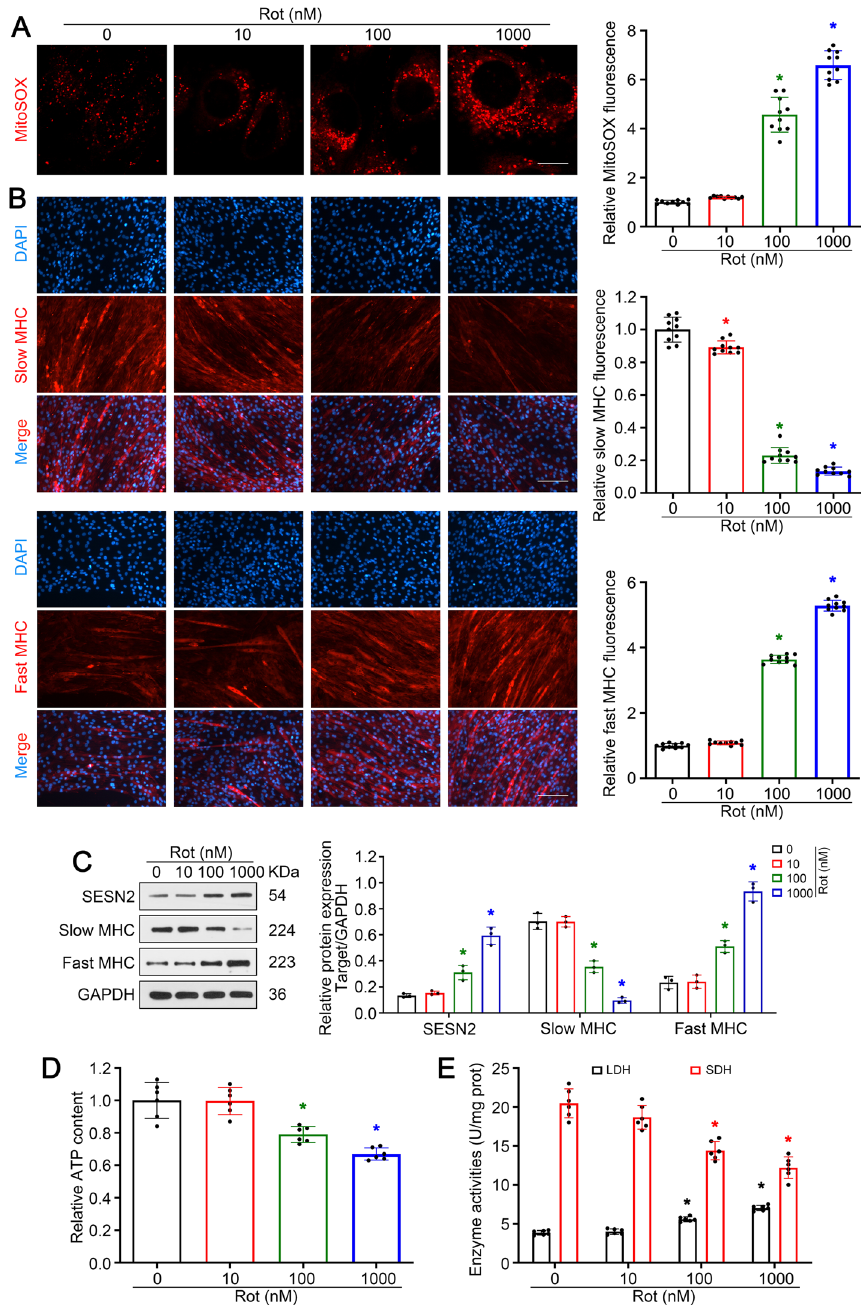
Fig. 3 Rotenone induced slow-to-fast fiber type shift in C2C12 myotubes. A Mitochondrial ROS levels in C2C12 cells were detected by MitoSOX Red labeling. Scale bar, 10 μm. B Immunofluorescence analysis of slow and fast MHC. Scale bar, 50 μm. C Western blot analysis of slow and fast MHC. D , E Detection of relative ATP content and metabolic enzyme activity (LDH and SDH) in C2C12 myotubes. Data presented as mean SD. * P < 0.05 versus control (0 nM rotenone treatment). Rot ±